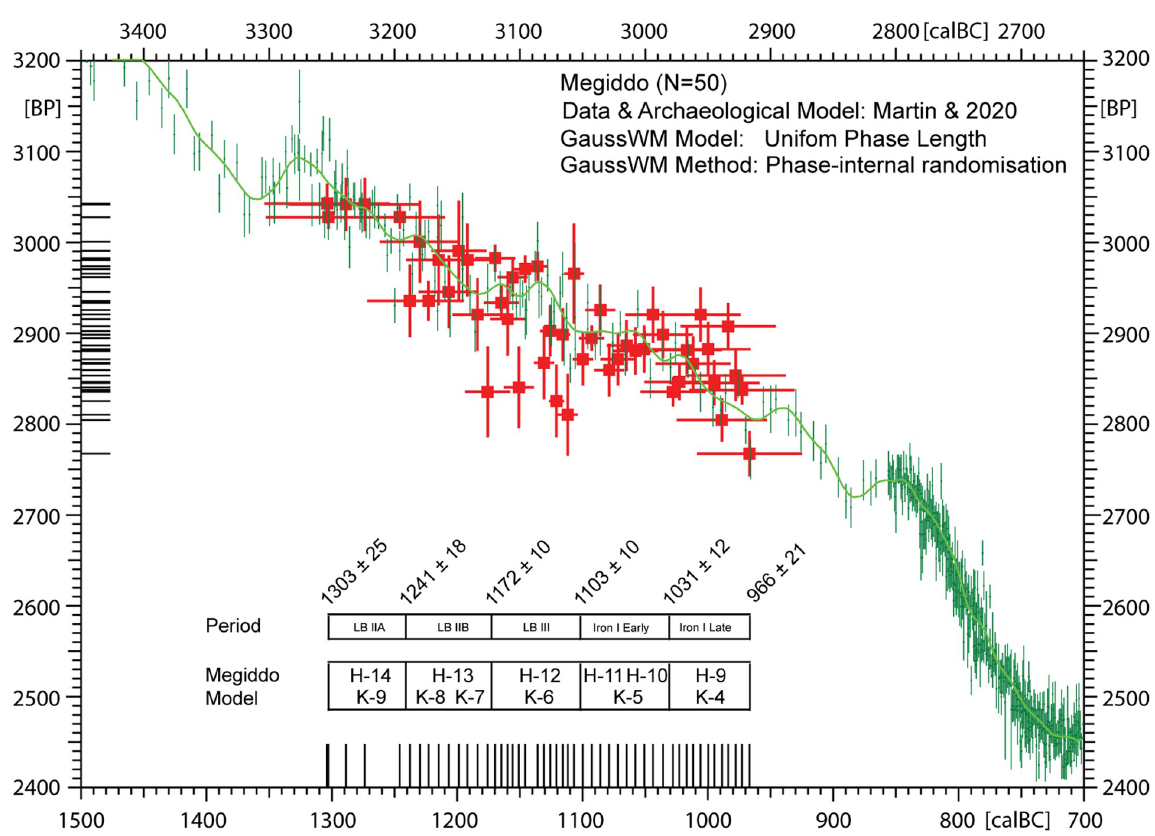
Fig 34. GaussWM-derived chronology for Megiddo based on the same 14 C-data (N = 50) and archaeological age-model as published by [40].